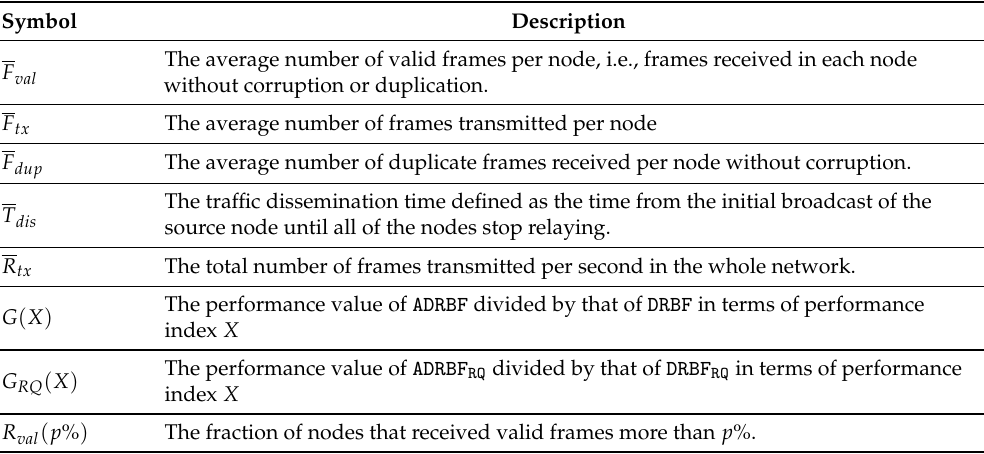
Table 1. The performance indices and their